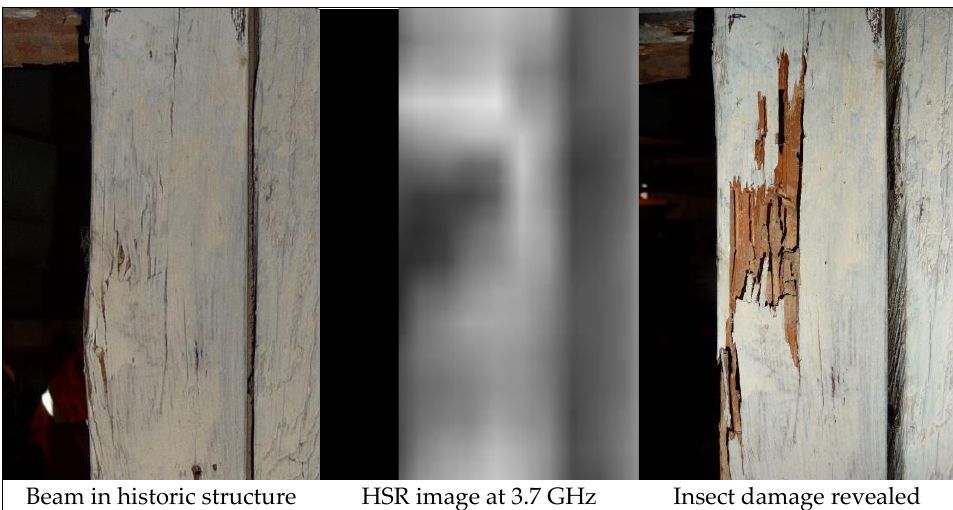
Figure 32. Wooden beam in a historic structure with insect damage detected and revealed.